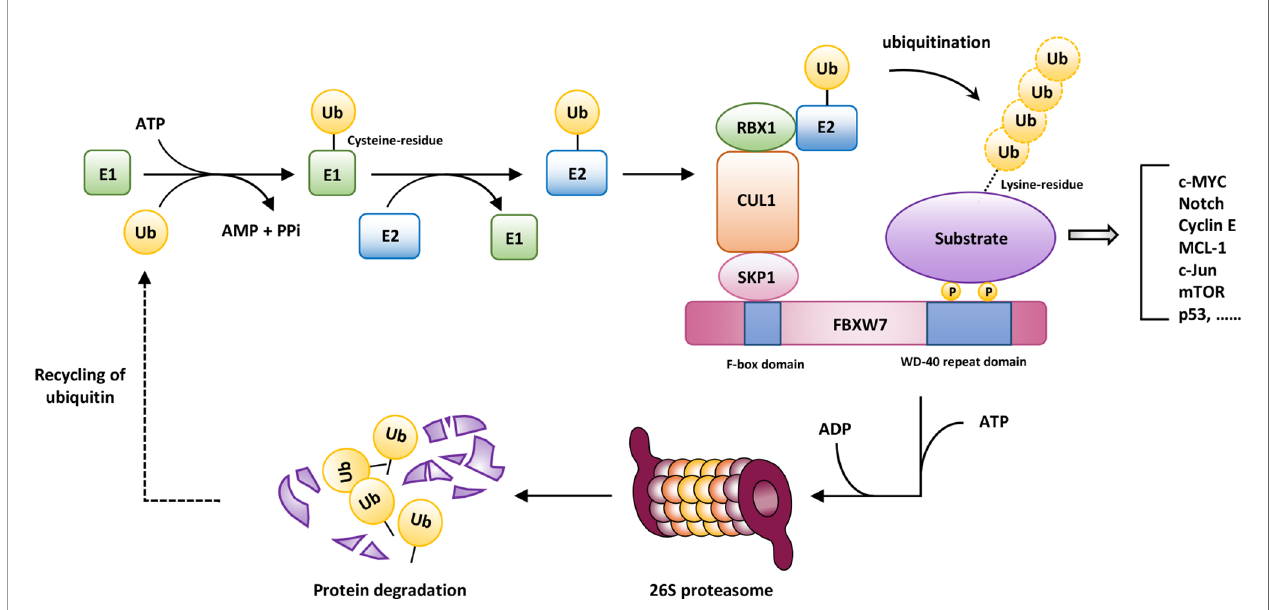
FIGURE 1 | The ubiquitin-mediated degradation involved in FBXW7. After the ATP-dependent activation triggered by the ubiquitin-activating enzyme (E1), the 76- amino-acid-residue protein ubiquitin binds to E1 in a thiolester linkage. Then, ubiquitin (Ub) is transferred to the ubiquitin-conjugating enzyme (E2), and subsequently transferred through the ubiquitin ligase (E3) to substrate proteins. Afterwards, a polyubiquitin chain can be formed for further degradation by 26S proteasome complex, conferring the recycling of ubiquitin. AMP, adenosine monophosphate; ATP, adenosine triphosphate; CUL1, cullin 1; RBX1, RING-box 1; SKP1, S-phase kinase- associated protein